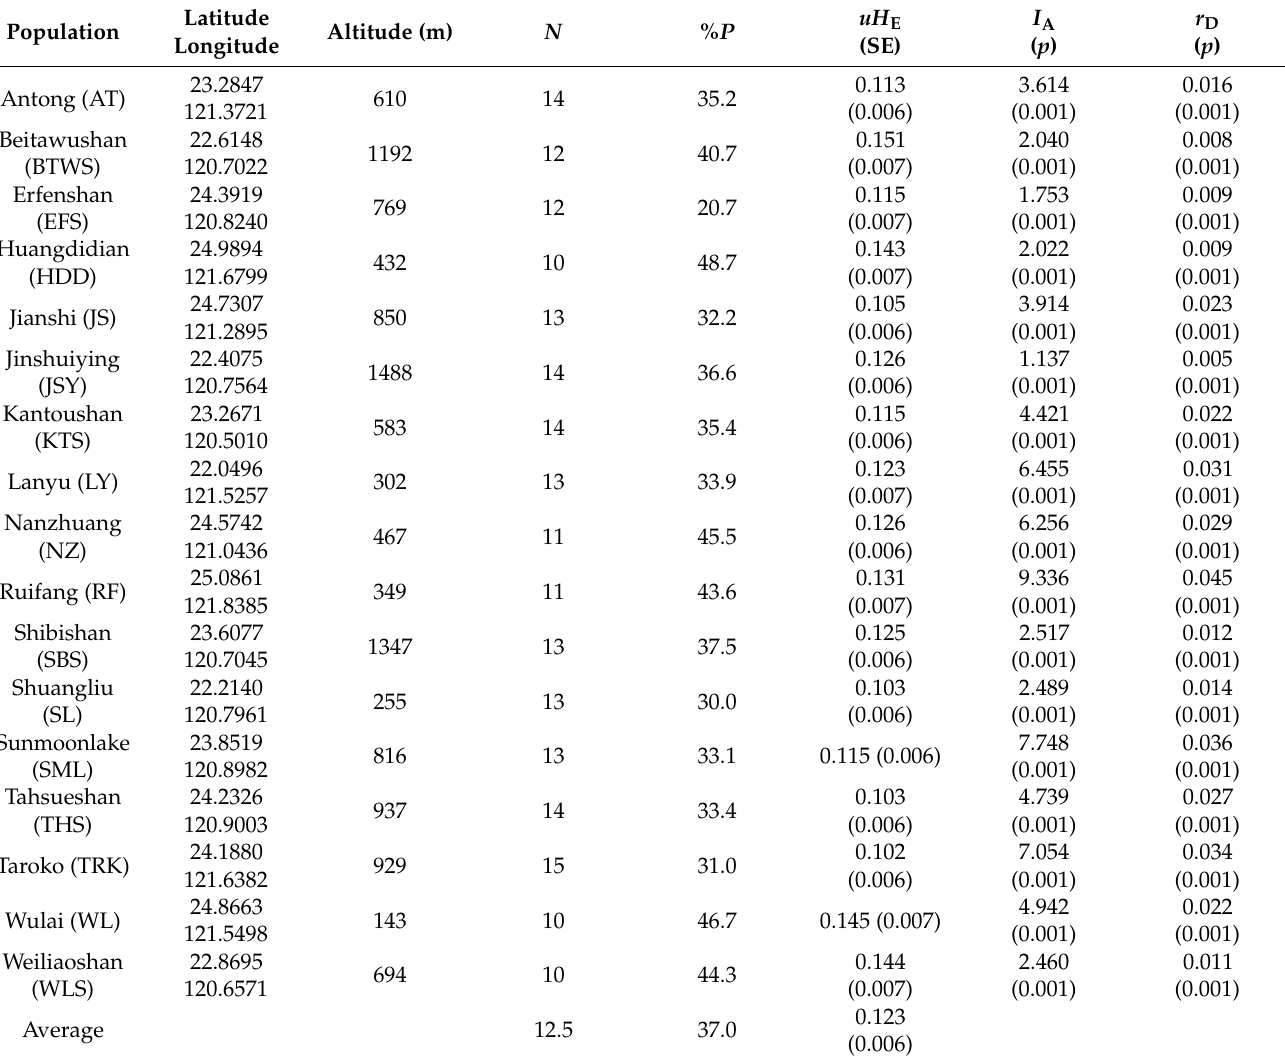
Table 2. Site properties and genetic parameters of the 17 sampled populations of Zingiber kawagoii estimated based on the total AFLP